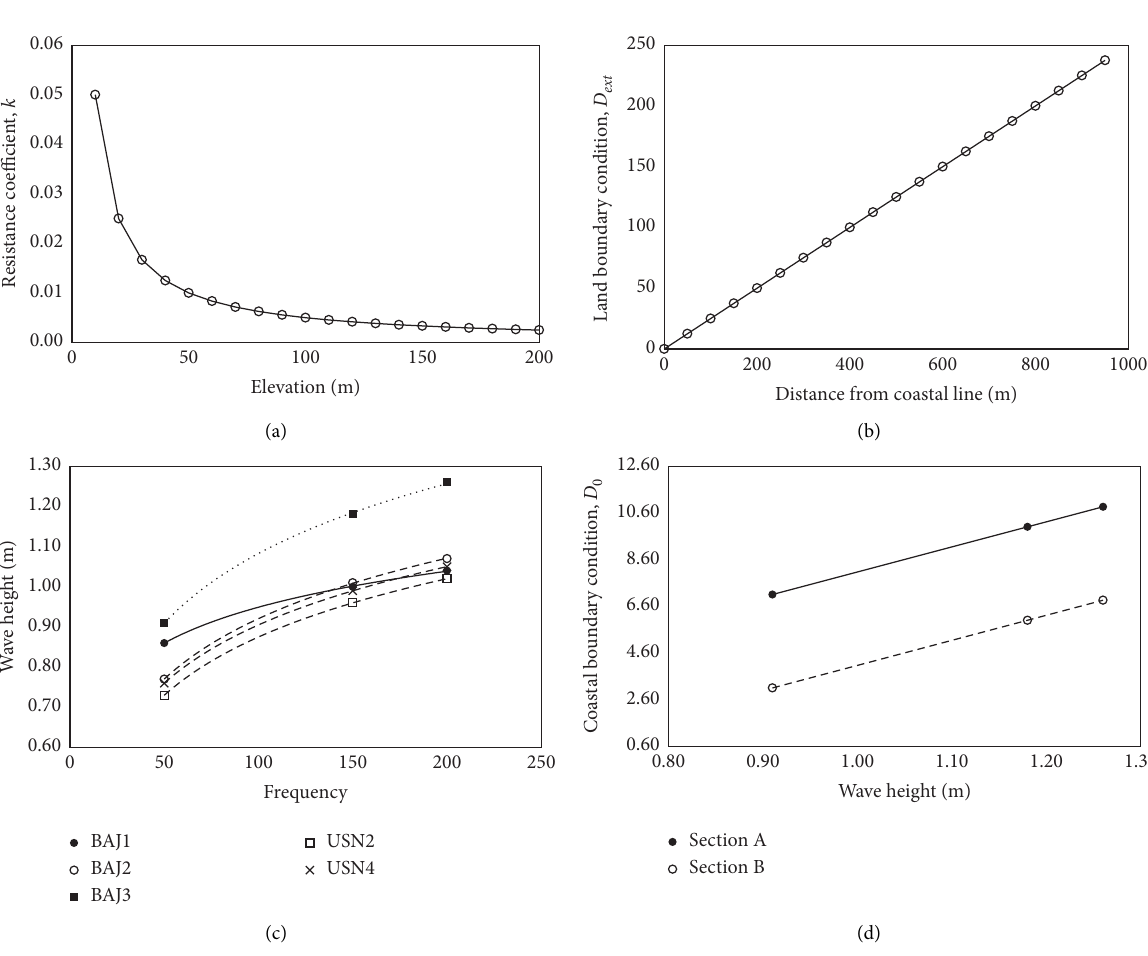
Figure 6: Results of coefficient and boundary conditions: (a) resistance coefficient with elevation; (b) land boundary conditions with d; (c) wave height with frequency; (d) coastal boundary conditions with H. Table 3: Results of overall shape similarity ( S ).